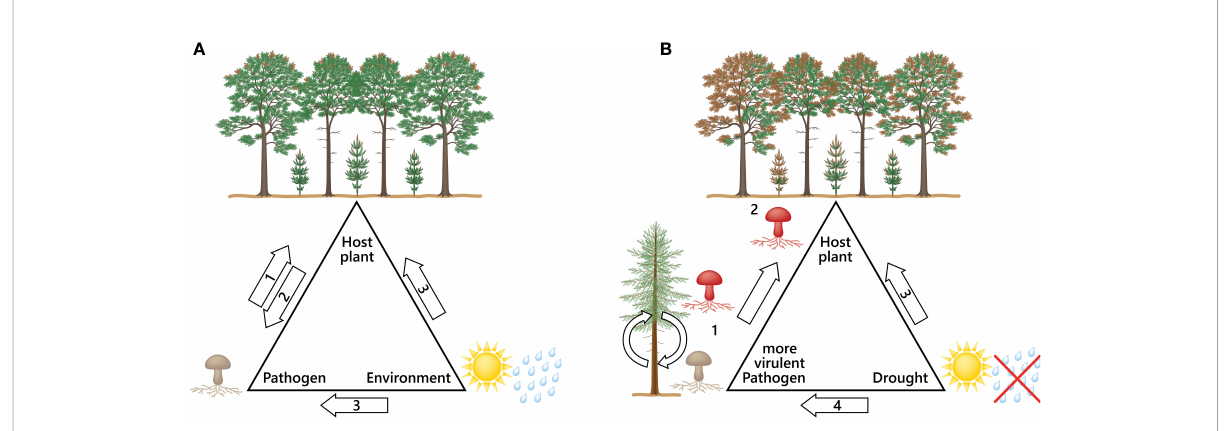
FIGURE 4 Disease triangles; (A) The disease triangle describes the factors involved for a disease to appear: (1) The virulence, distribution and infection capacity of a pathogen; (2) Host immune system; (3) suitable environmental conditions that bene fi t the pathogen and cause stress to the host. (B) Disease triangle with a scenario leading to severe outbreaks of pathogens: (1) Pathogen settles to a new host (host-jump; putative activation of more pathogenicity genes) leading to a more aggressive pathogen; (2) More aggressive pathogen can now infect its typical host with higher virulence leading to more devastating symptoms; (3) Drought weakens the host tree and makes it even more susceptible to pathogens; (4) Environmental change can bene fi t emerging and invasive pathogens leading to new host species and evolution of more aggressive